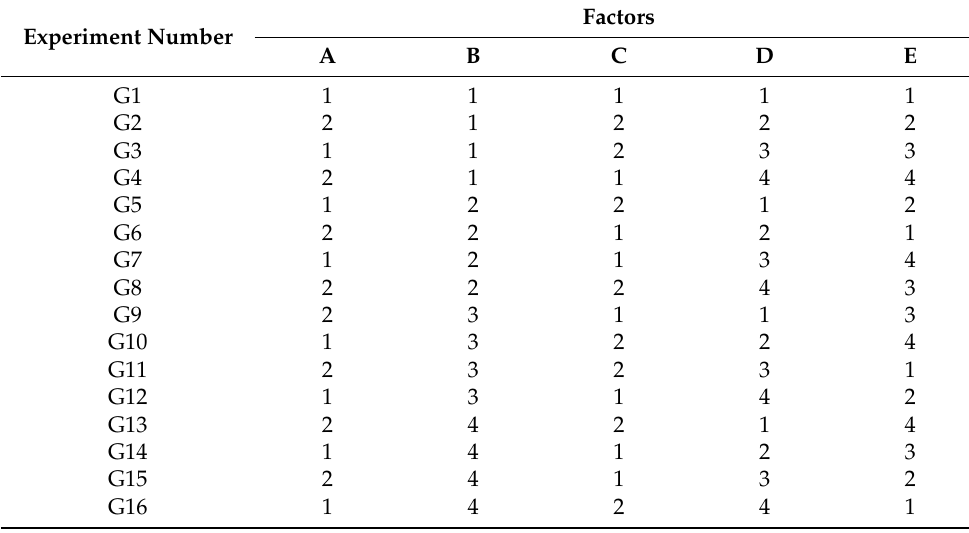
Table 2. Orthogonal table L16